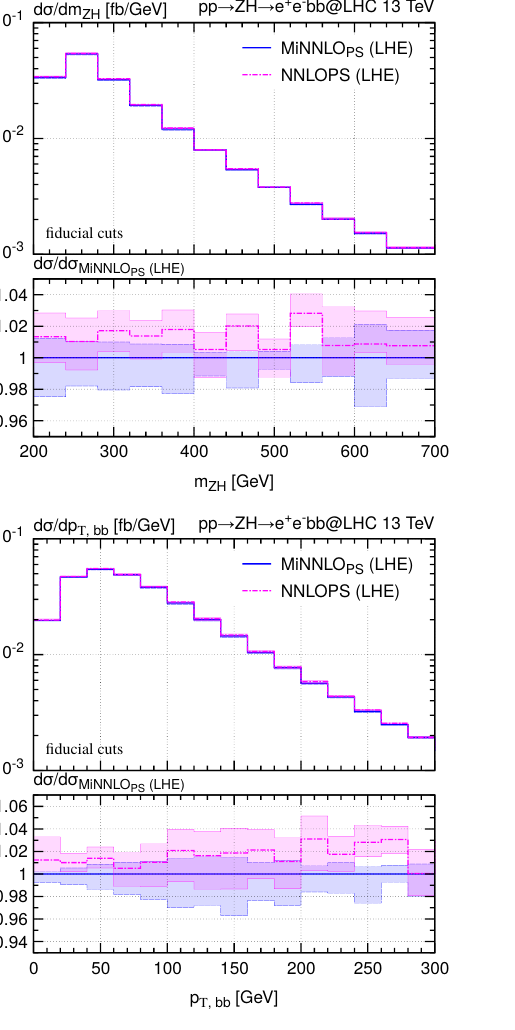
Figure 3 . Comparison of MiNNLO PS and NNLOPS predictions for e + e − b ¯ b production with the fiducial cuts quoted in table